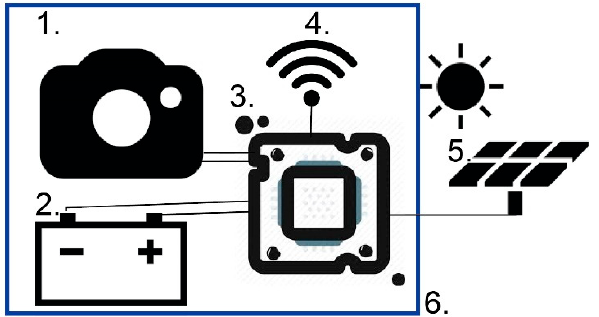
Figure 3. Long-term time lapse system components: (1) Camera and fixed lens; (2) battery; (3) microcomputer to control power supply, to trigger photos on a schedule, and to upload pictures to a server for data processing; (4) a wireless internet connection; (5) a power supply such as solar panels; (6) a protective housing.